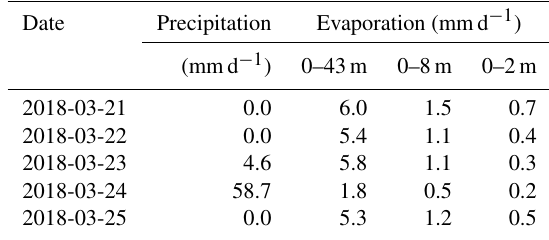
Table 1. Daily summary of precipitation and evaporation at 43, 8, and 2m height according to Jiménez-Rodríguez et al. (2020) for the experimental site during the monitoring